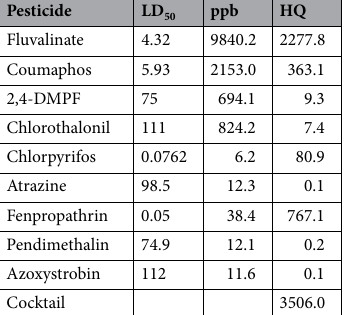
Table 3. Composition of the 9-component cocktail used for the field trial, derived from Traynor et al . 10